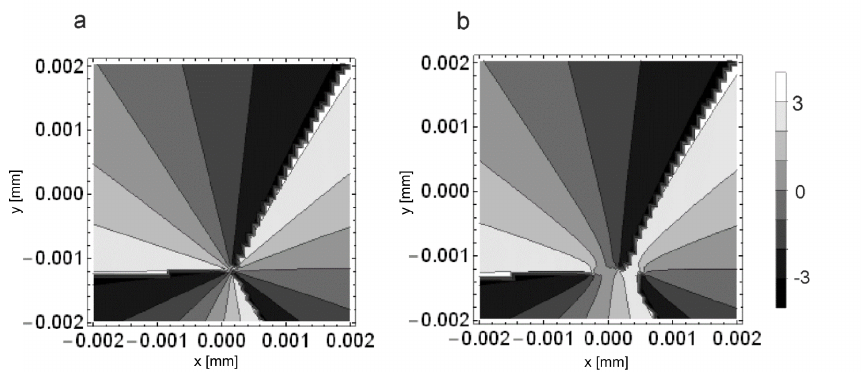
Figure 6. The phase image of focused vortex beam (parameters as in Figure 2b), m = 3; ( a ) calculated from Kappa function with n = 21. The higher order vortex is still there; ( b ) calculated from Kappa function with n = 21, but the number 0.05 was added to binomial factor in the second sum for n = 1. The vortex was split into three single